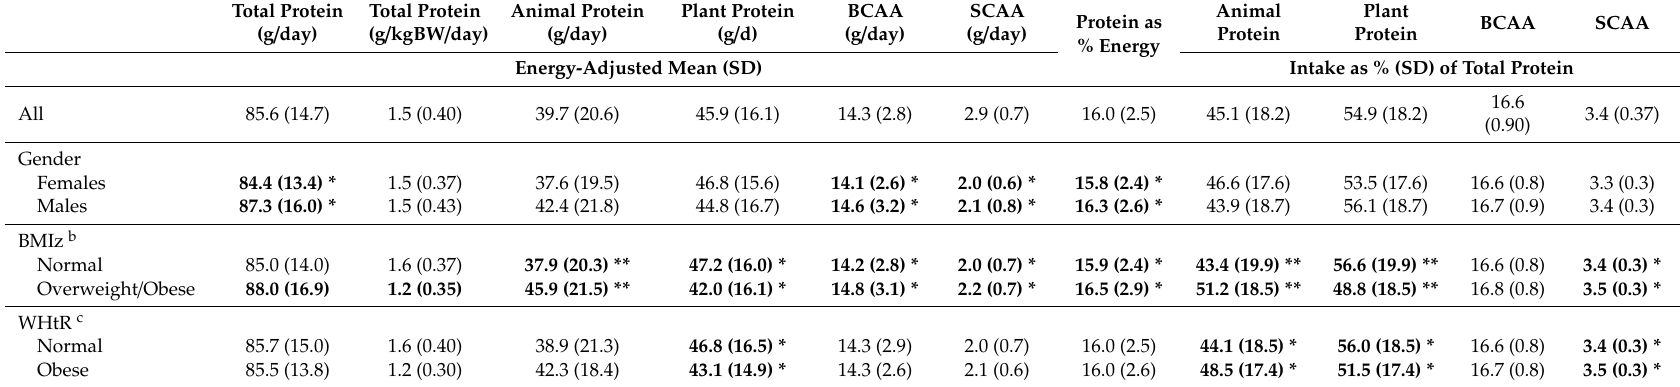
Table 3. Estimated energy-adjusted a means (SD) of total, animal and plant proteins, branched-chain amino acids (BCAAs), and sulfur-containing amino acids (SCAAs) intake and percent contribution to total protein intake according to gender, weight status, and central adiposity.